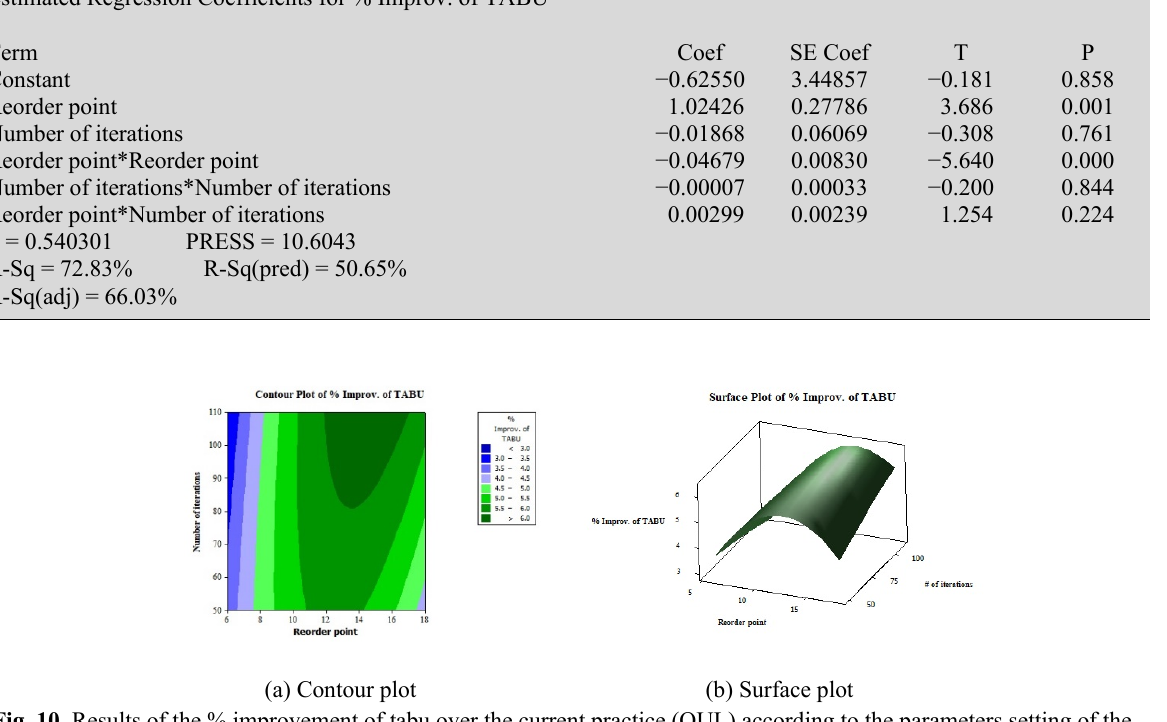
Fig. 10. Results of the % improvement of tabu over the current practice (OUL) according to the parameters setting of the